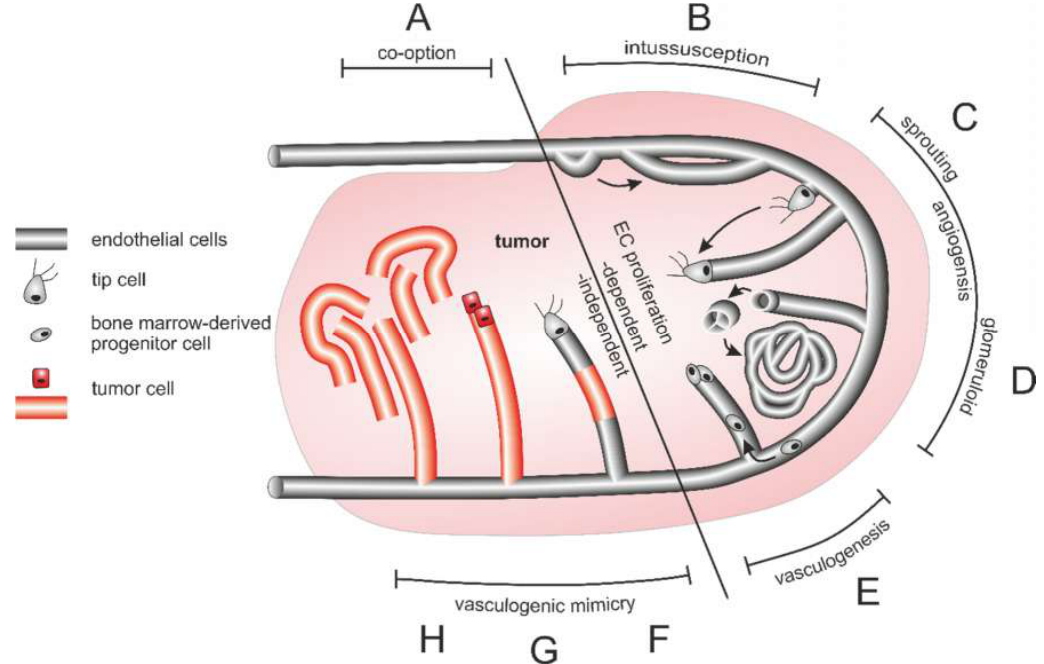
Figure 4. Different origins of the tumor vasculature. ( A ) Vessel co-option, ( B ) intussusception ( C ) sprouting angiogenesis, ( D ) glomeruloid angiogenesis, ( E ) vasculogenesis from bone marrow-derived progenitor cells, and vasculogenic mimicry in the form of ( F ) composites vessels, as well as ( G ) tubular type and ( H ) patterned type vasculogenic mimicry occur side by side and can also merge into each other. Of importance for tumor therapy is that vessel cooption and vasculogenic mimicry are independent of endothelial cell proliferation in contrast to intussusception, angiogenesis and vasculogenesis.